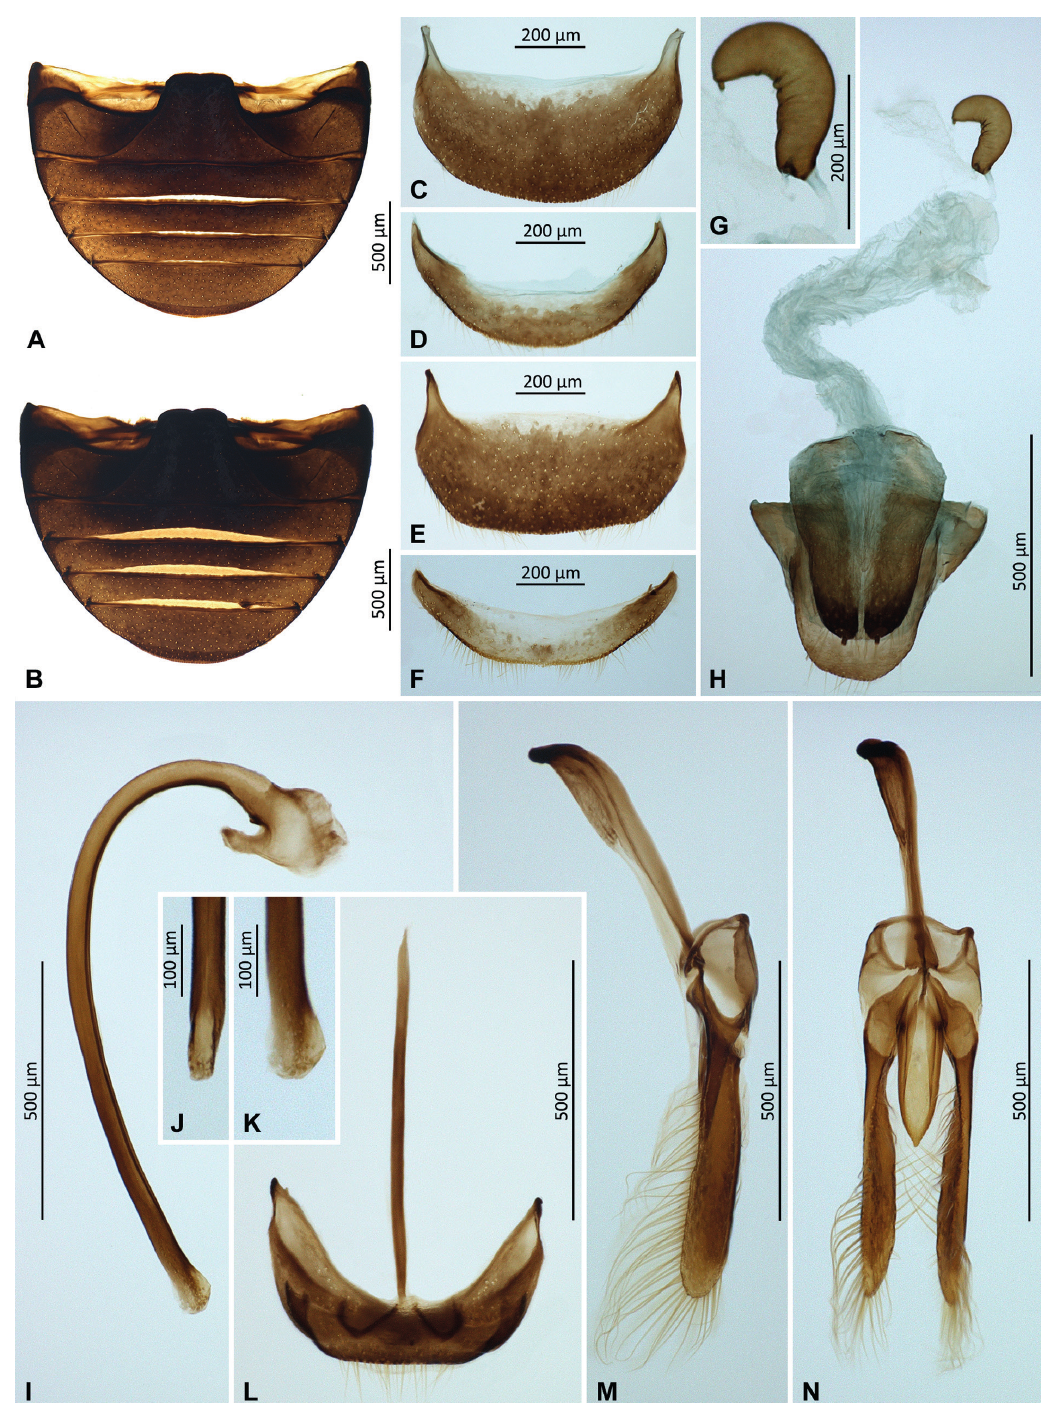
Fig. 7. Chnoodes yanayacu sp. nov. A . Paratype (MNHW), ♀, abdomen. B . Holotype (MNHW), ♂, abdomen. C . Paratype (MNHW), ♀, tergite VIII. D . Paratype (MNHW), ♀, sternite VIII. E . Holotype (MNHW), ♂, tergite VIII. F . Holotype (MNHW), ♂, sternite VIII. G . Paratype (MNHW), spermatheca. H . Paratype (MNHW), ♀, genitalia, ventral. I . Holotype (MNHW), penis, lateral. J . Holotype (MNHW), penis tip, inner view. K . Holotype (MNHW), penis tip, lateral view. L . Holotype (MNHW), ♂, segments IX and X, dorsal view. M . Holotype (MNHW), tegmen, lateral view. N . Holotype (MNHW), tegmen, inner